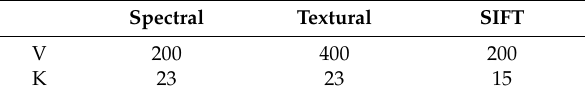
Table 7. Best Table 7. Best parameter.